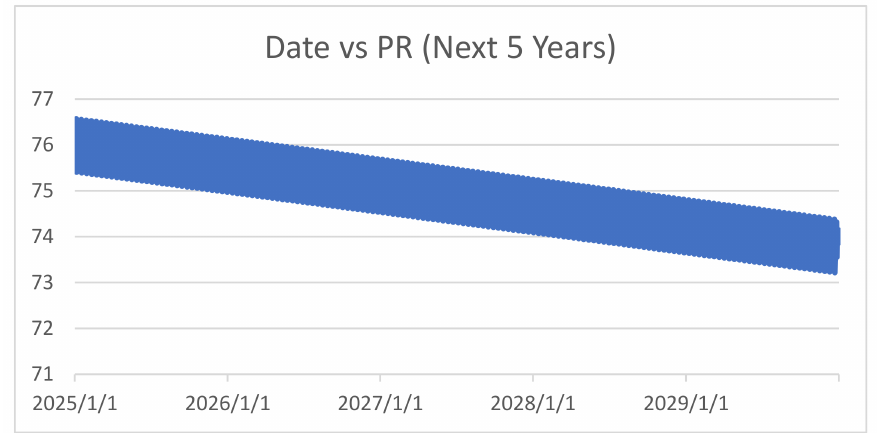
Figure 15. Second 5 years’ prediction results for the performance ratio from 1 January 2025 to 1 January